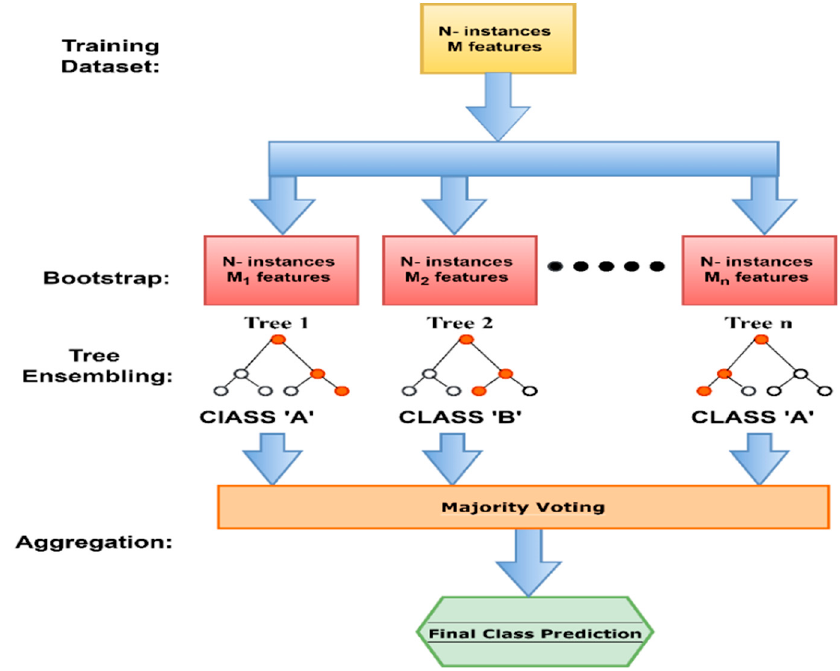
Figure 7. An example of the operation flow diagram of a random forest classifier. Table 4. Parameter used in random forest